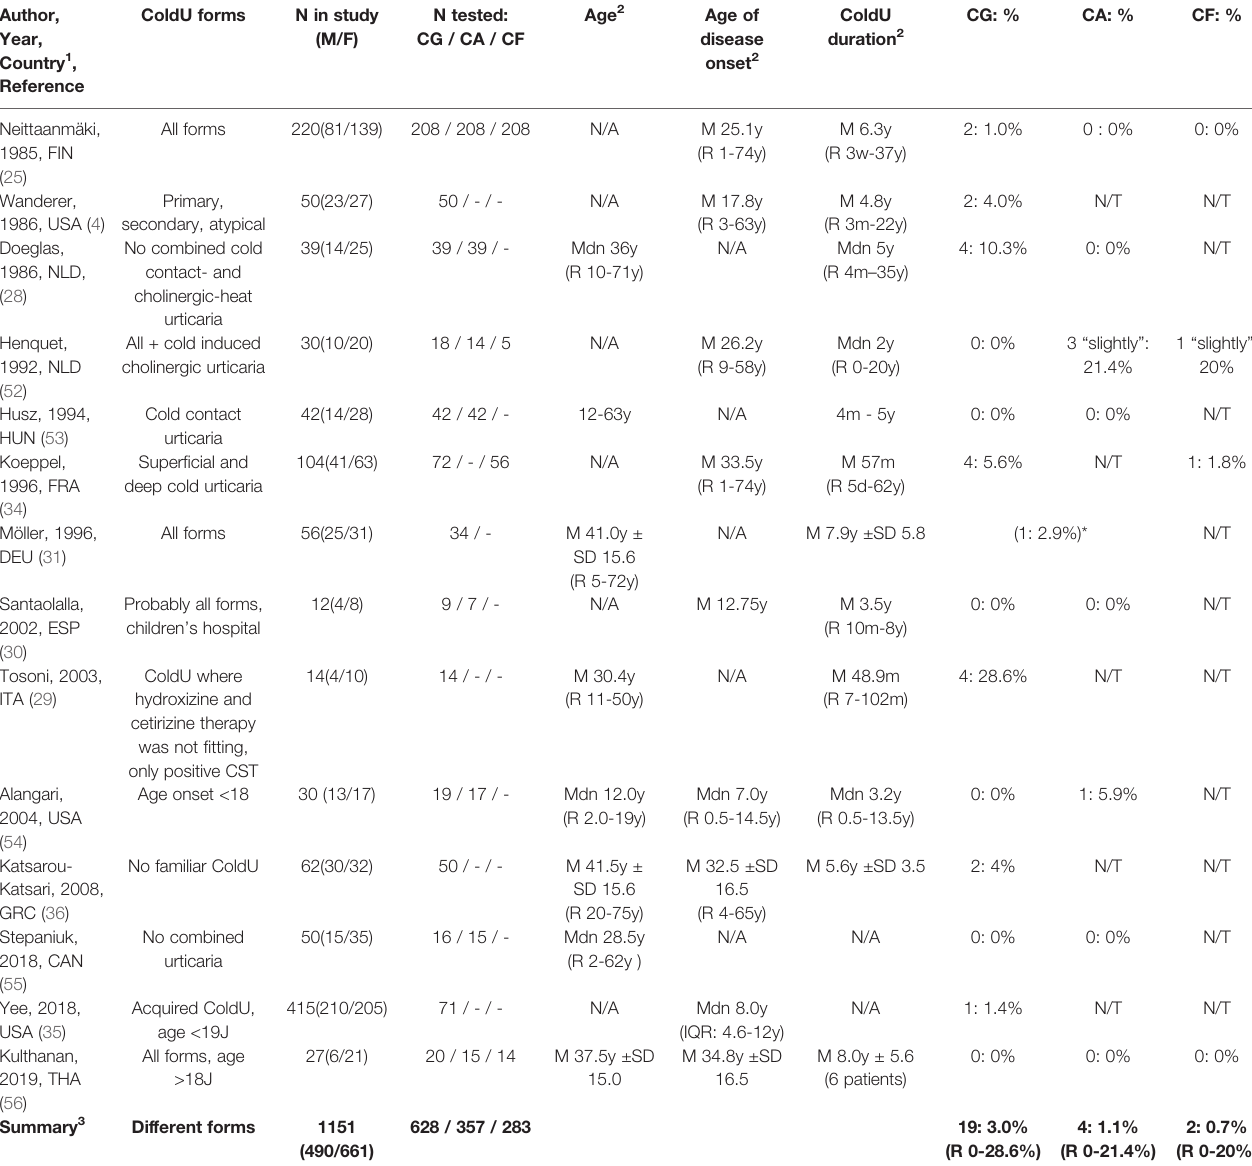
TABLE 2 | Overview of the existing literature on ColdU and the rate of positive